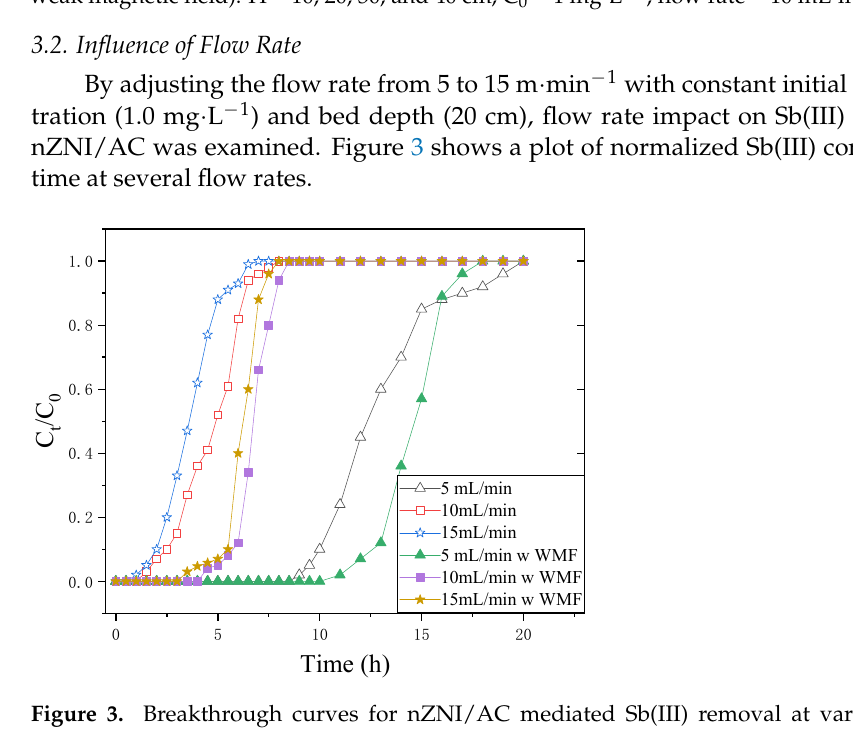
Figure 2. Breakthrough curves of Sb(III) removal by nZNI/AC for different bed depths (wWMF = with weak magnetic field). H = 10, 20, 30, and 40 cm; C 0 = 1 mg·L − 1 ; flow rate = 10 mL·min − 1 ; pH = 7.